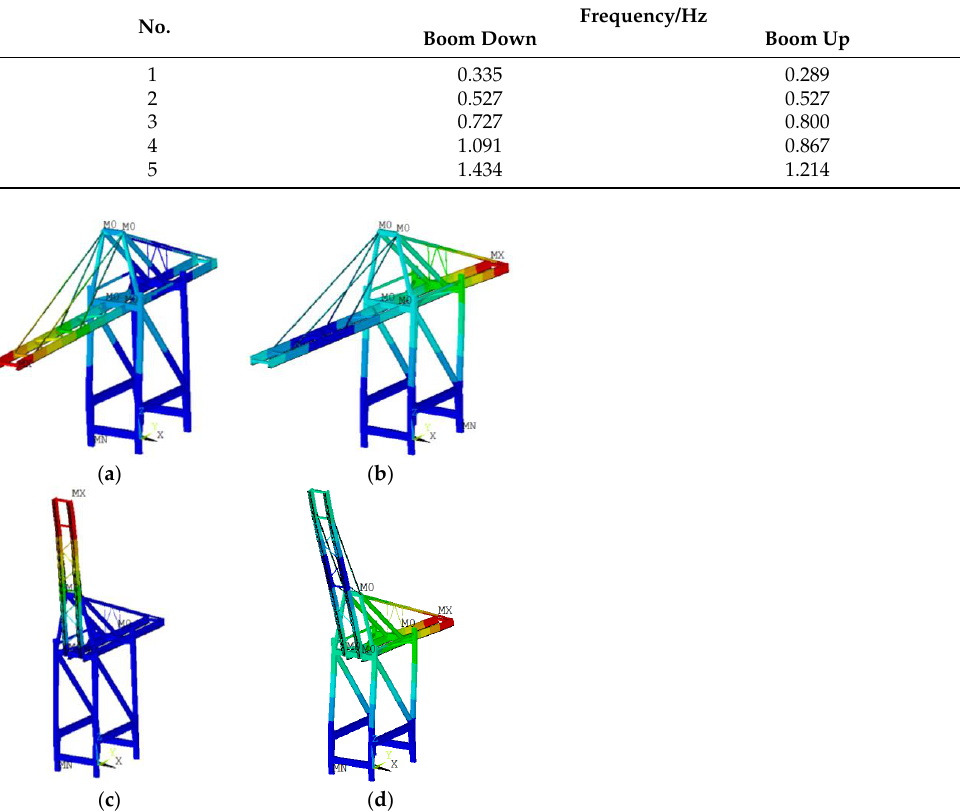
Table 8. The first five natural frequencies of the quayside container crane models.